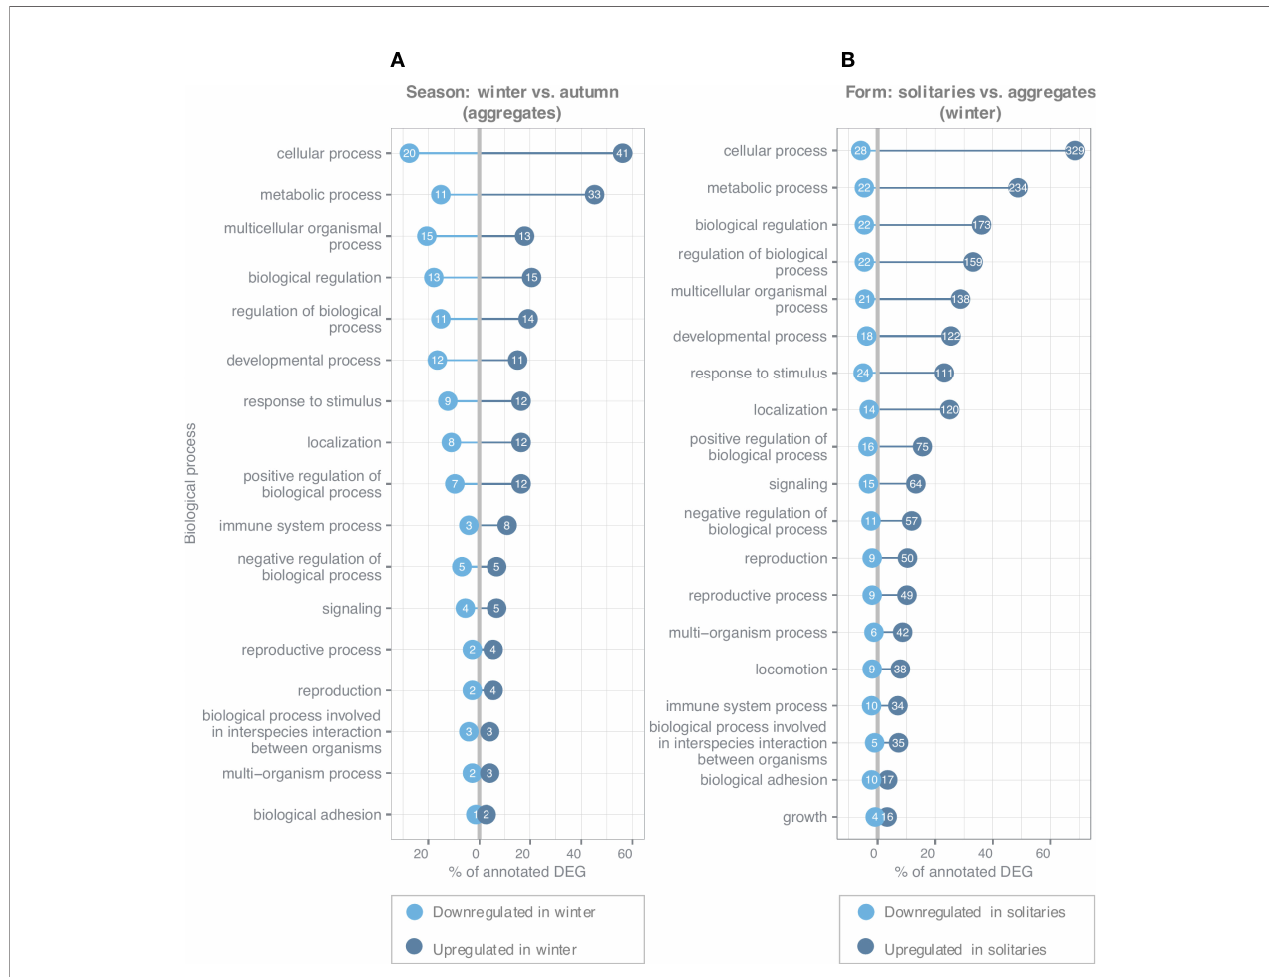
FIGURE 5 | Distribution of Gene Ontology terms summarized at second level of biological processes for (A) differentially expressed genes (DEG) between seasons (winter vs. autumn) in aggregates and (B) differentially expressed genes between forms (solitaries vs. aggregates) in winter. Up- and downregulated refer to the number of genes which were found up- or down- regulated in (A) winter compared to autumn or in (B) solitaries compared to aggregates within the respective term. Numbers in circles indicate the absolute number of genes assigned to each category, while the x-axis indicates the respective percentage of all annotated differentially expressed genes [ (A) 73/34.93% annotation and (B) 480/62.18% annotation]. Only categories that were assigned to at least 4% of annotated genes are